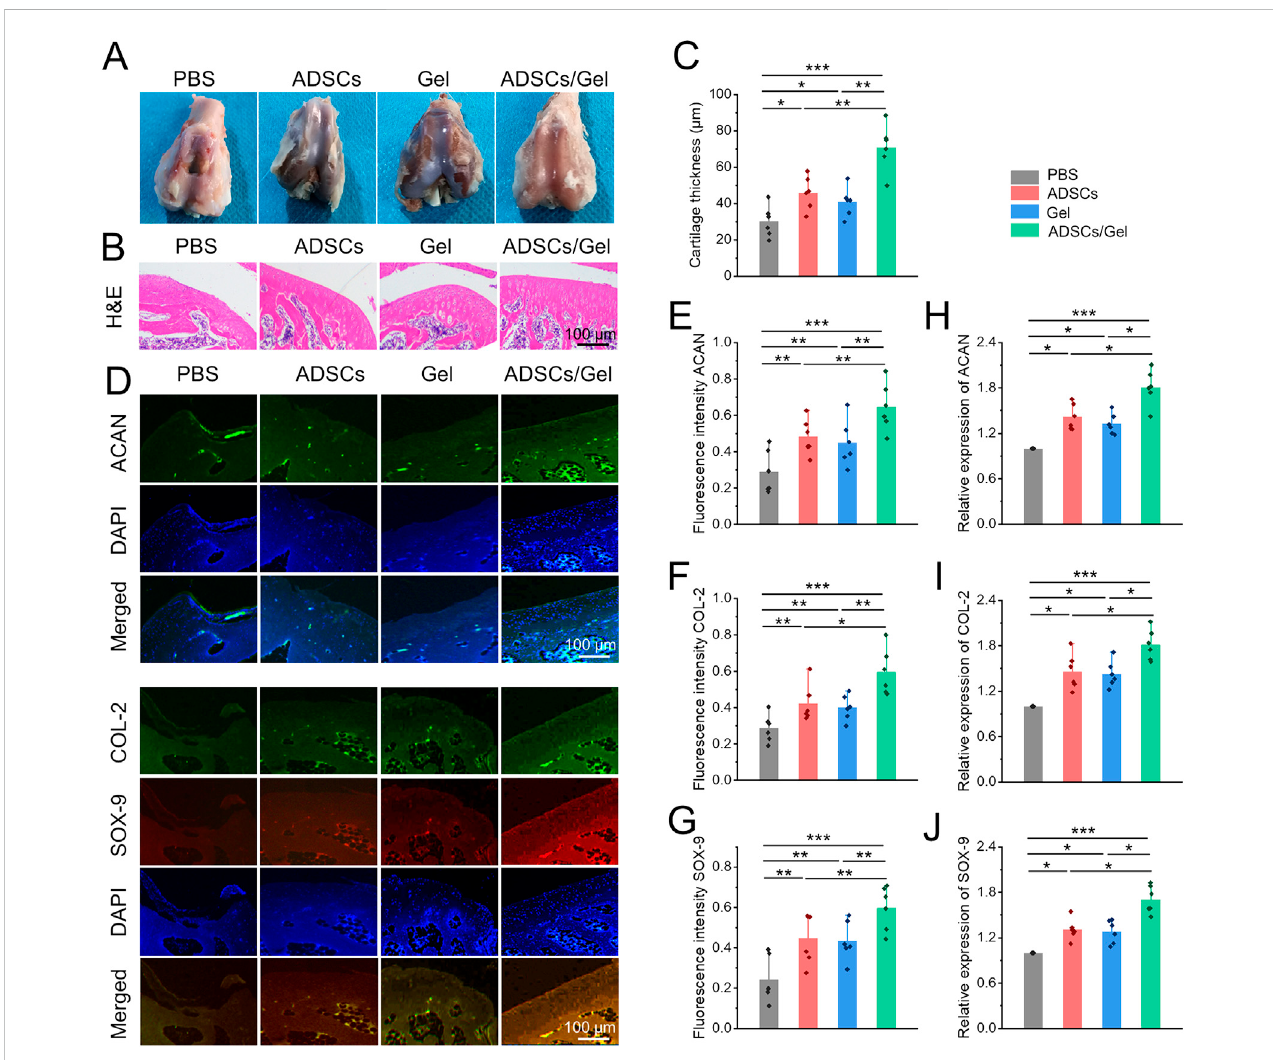
FIGURE 8 Intra-articular injection of ADSCs loaded HA-EGCG hydrogel repair the damaged cartilage in OA. (A) Gross observation of articular cartilages. (B) H&E staining of articular cartilage. (C) Quantitative analysis of the thickness of articular cartilage ( n = 6). (D) Immuno fl uorescence of ACAN, COL-2, and COX-9 of thecartilage samples. (E – G) Quantitativeanalysisof fl uorescenceintensityofACAN,COL-2,andCOX-9intheimages( n =6). (H – J) Real-timePCRdetection the mRNA expression of ACAN, COL-2, and COX-9 in the cartilage samples (n = 6) (* p < 0.05, ** p < 0.01, and *** p <